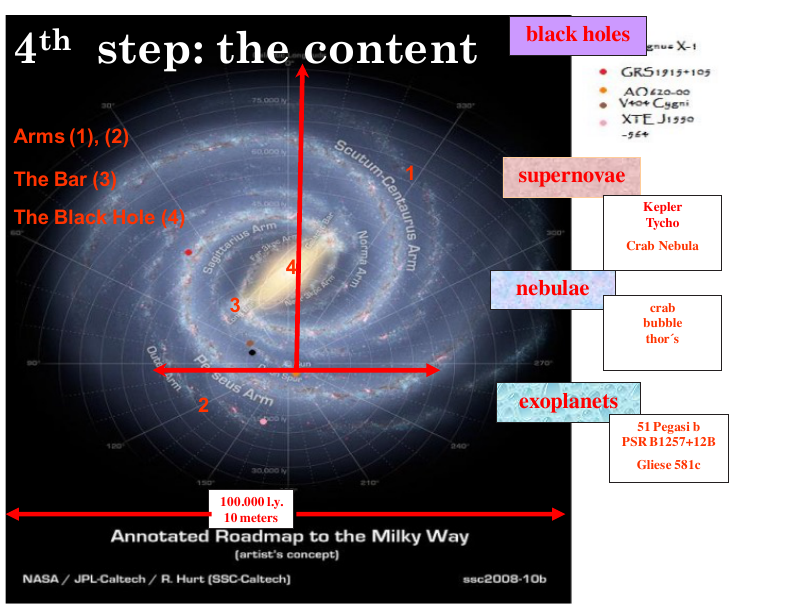
Fig.3 The content of our Galactic